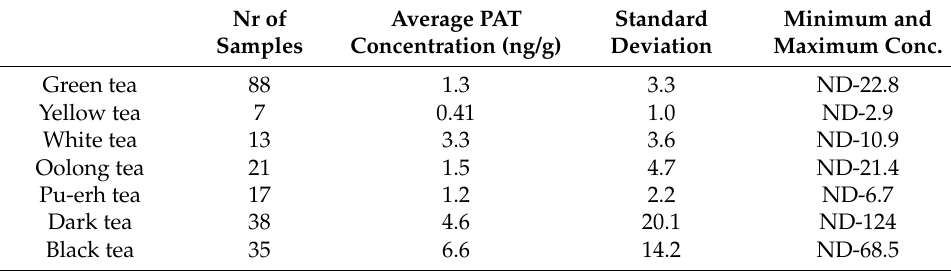
Table 4. Average, minimal and maximum PAT content of different types of